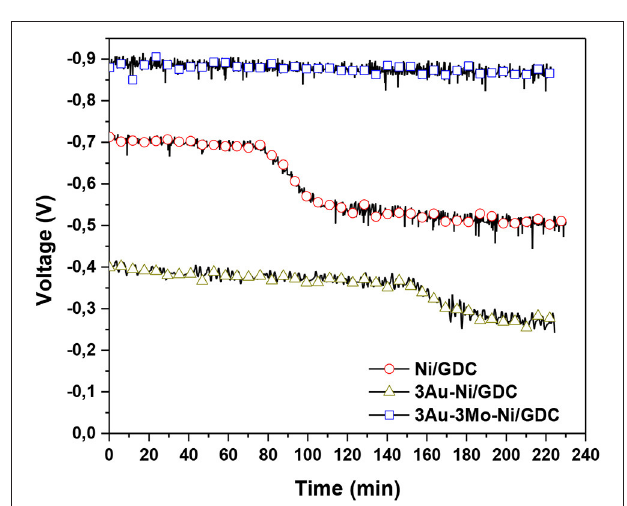
FIGURE 18 | Stability diagrams of blank and Au-Mo modified “ low-AFL ” Ni/GDC anodes under 10 ppm H 2 S/H 2 . The experiments were performed at T = 850 ◦ C, j = 28 mA/cm 2 and F total = 100 cc/min. Reprinted with permission from Neofytidis et al. (2015).